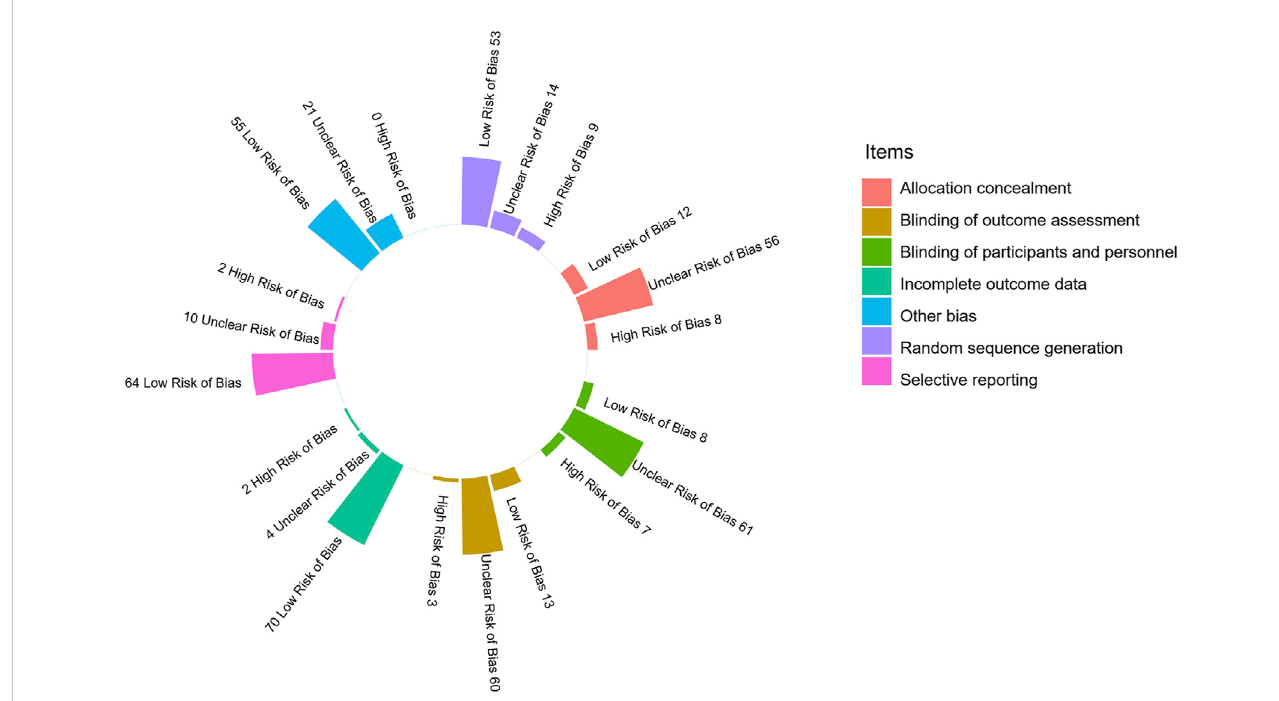
FIGURE 2 Risk of bias assessment of the included 76 randomized controlled